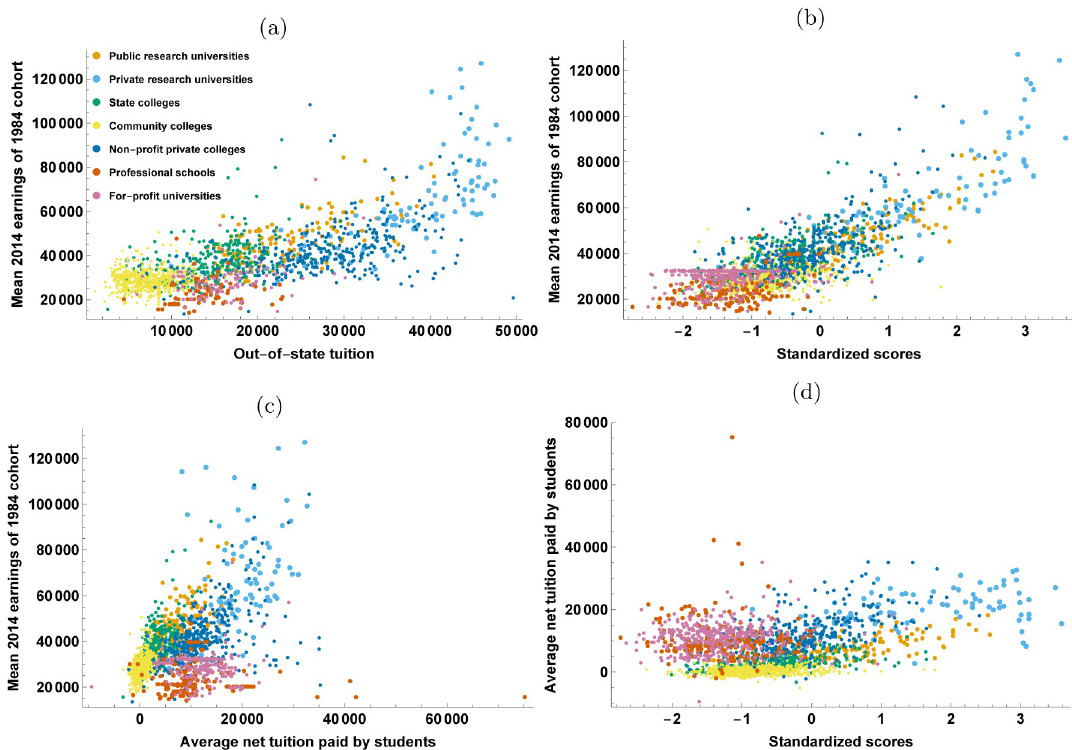
Fig 4. Student outcomes. Relationship between mid-career earnings of graduates and schools’ tuitions and selectivity (See SI Figs H1, H2 in S1 File for robustness of relationships to alternative choices of some of these variables).